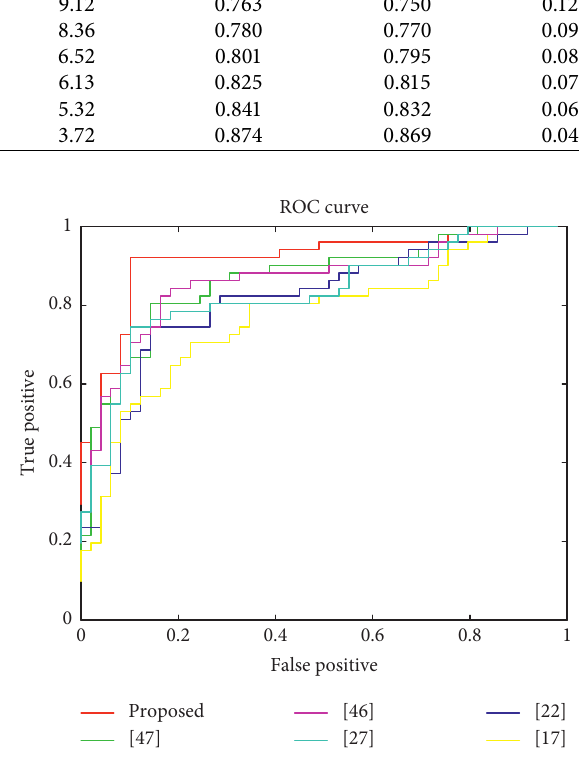
Figure 13: The ROC curves of different